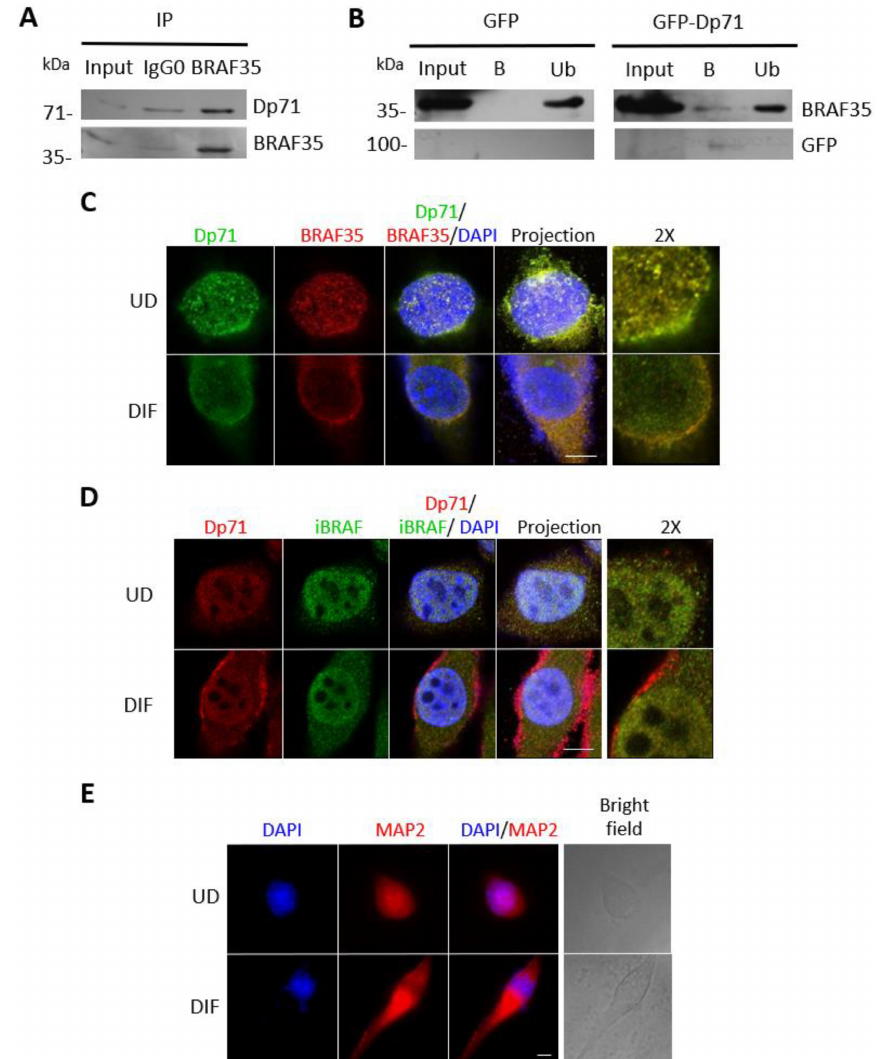
Figure 7. Dp71 interacts with BRAF35 and colocalizes with BRAF35 and iBRAF during the neuronal differentiation of N1E-115 cells. ( A ) N1E-115 cell lysates were subject to immunoprecipitation (IP) using anti-BRAF35 antibodies and the immunoprecipitated proteins were analyzed by Western blotting using antibodies against Dp71 and BRAF35. ( B ) Lysates from N1E-115 cells transiently expressing GFP or GFP-Dp71 were immunoprecipitated using the GFP-Trap system. The captured proteins were subjected to Western blot analysis using antibodies against BRAF35 and GFP. Input corresponds to 5% of protein lysates prior to immunoprecipitation; IgG0, nonspecific antibody; Ub, unbound proteins; B, bound proteins. Undifferentiated (UD) and differentiated (DIF) N1E- 115 cells were immunostained with ( C ) anti-BRAF35 or ( D ) anti-iBRAF antibodies and anti-Dp71 and were antibody and counterstained with DAPI to visualize nuclei. ( E ) Undifferentiated and differentiated N1E-115 cells were immunostained for the neuronal differentiation marker MAP2 and counterstained with DAPI to visualize nuclei. Cells were imaged by CLSM, and representative single optical Z-sections are shown (scale bar = 10 µ